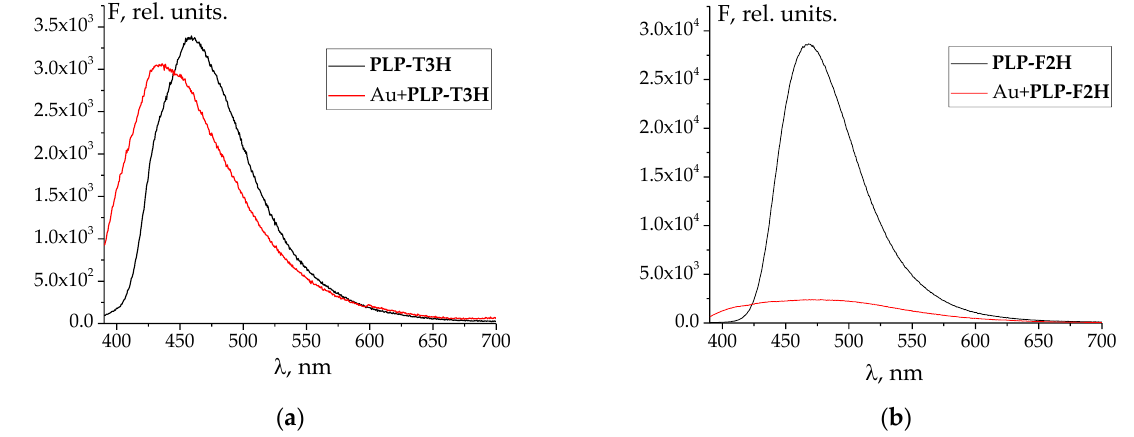
Figure 2. Emission spectra of free hydrazones and their mixtures with Au 3+ : ( a ) PLP-T3H ; ( b ) PLP-F2H . λ ex = 365 nm. Concentrations of ligands, metals, and H + are equal to those at the end of UV–Vis titration (see below).